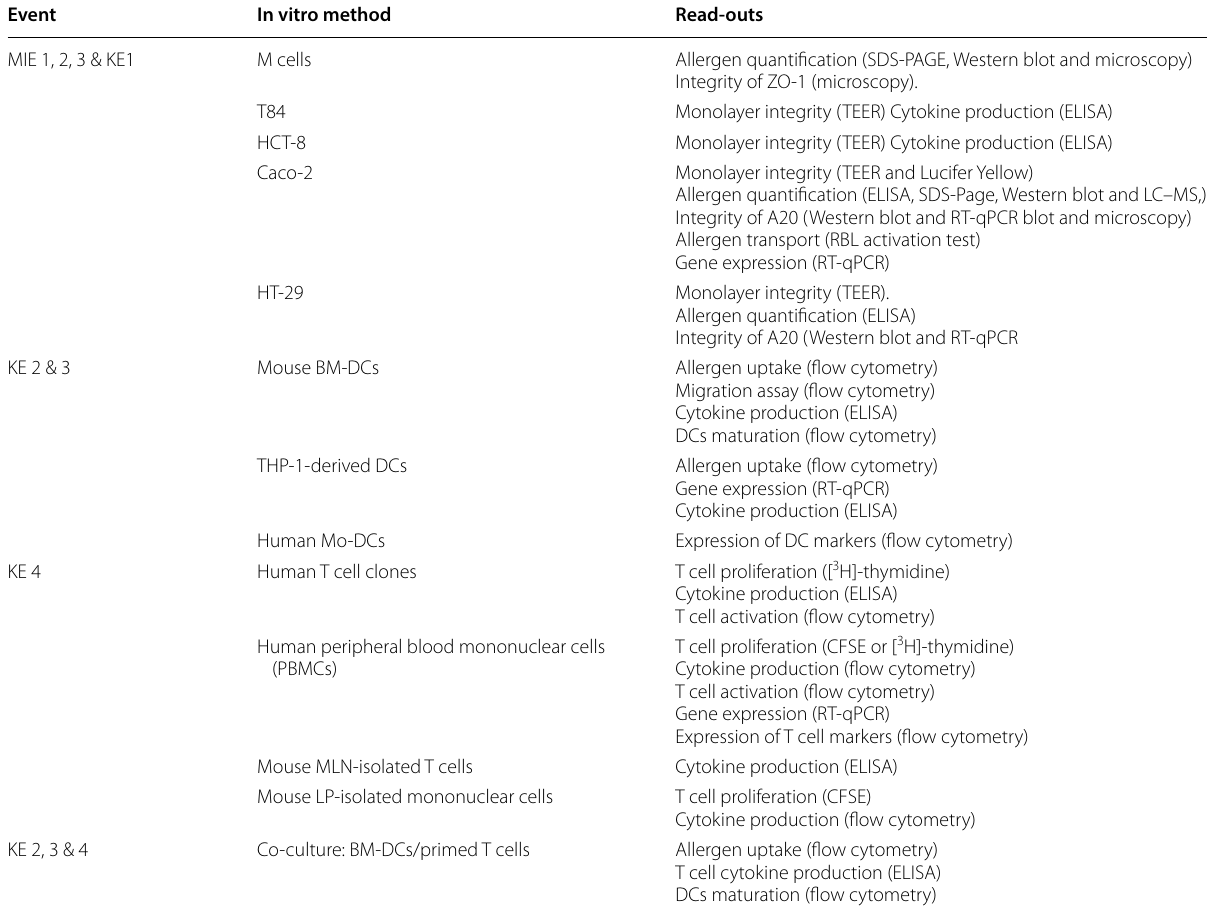
Table 3 Methods addressing several MIE’s and KE’s shown in Fig.